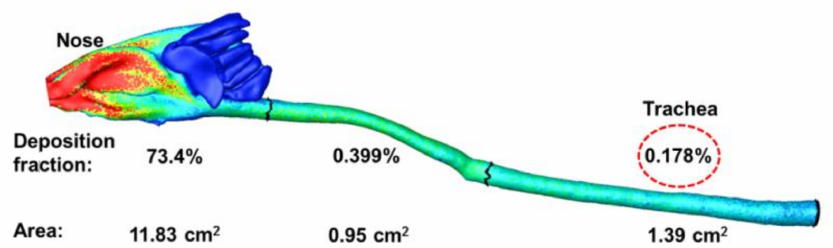
Figure 3. Dimension and deposition fraction of inhaled acrolein in three sub-regions: Nose, throat (pharynx-larynx), and